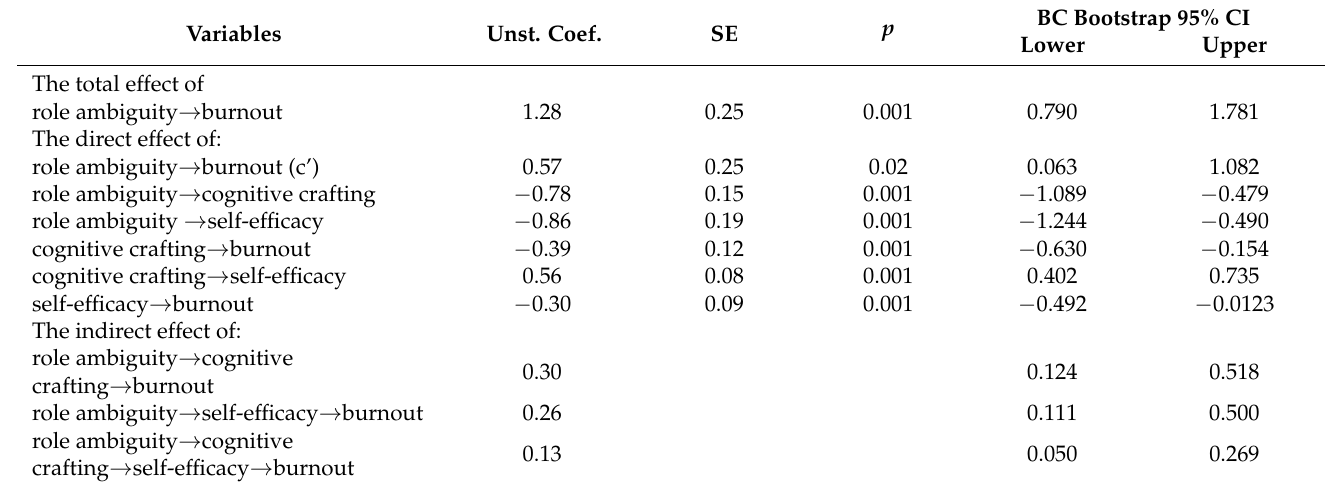
Table 5. Total, direct, and indirect effects of the mediation model 3—role ambiguity on burnout through cognitive crafting and self-efficacy (PROCESS).